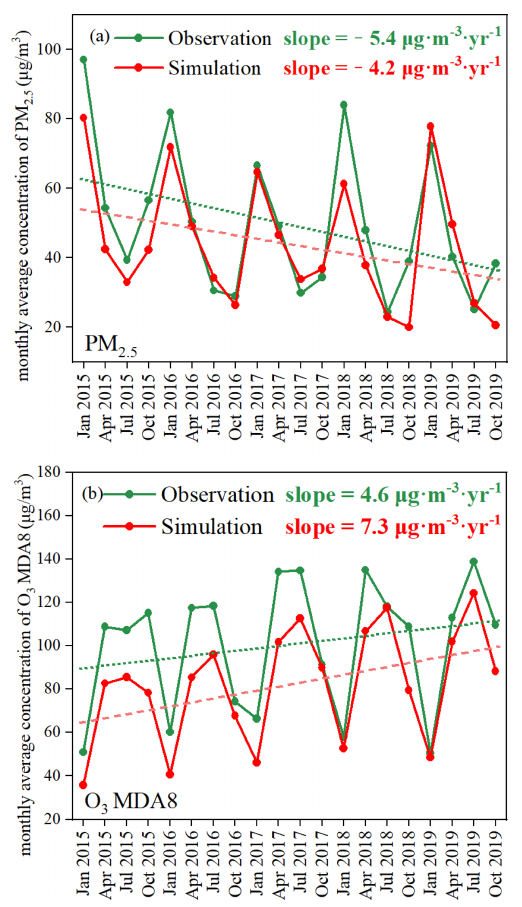
Figure 10. The monthly averages of (a) PM 2 . 5 and (b) MDA8 O 3 from CMAQ simulation and ground observation for January, April, July, and October from 2015 to 2019. The slopes of linear regressions in the panels indicate the annual variation rates for cor- responding